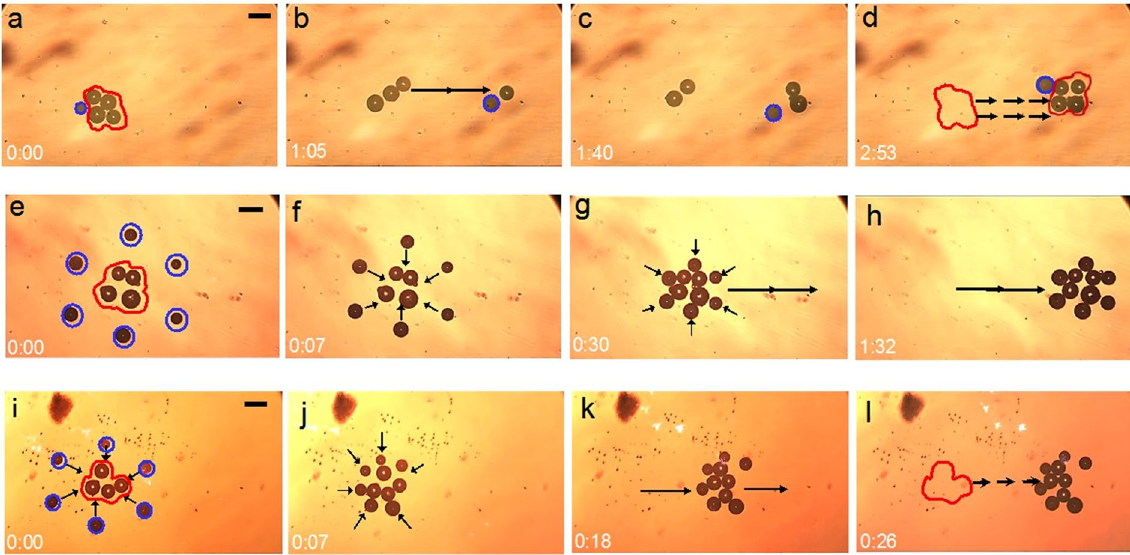
Figure 8. Cooperative microrobot transportation of multiple micro-objects. ( a–d ) An assembly of four glass beads was transported serially using a single OFB microrobot. ( a ) The OFB microrobot is circled in blue, and the four glass beads are enclosed by a red line. ( b–d ) The four glass beads were serially transported 844 µ m away from the initial location, over an assembly time of 2 minutes and 53 seconds. ( e–h ) Manually controlled cooperative microrobot transportation of multiple micro-objects. ( e ) Six microrobots are positioned equidistant from the glass beads. The microrobots are circled in blue, and the glass beads are enclosed by a red line. ( f ) The OFB microrobots were manually controlled to approach the beads to grasp them. ( g,h ) The glass beads were grasped by the microrobots, and the beads were transported to the delivery location. The assembly time was 1 minute, 32 seconds. ( i–l ) Automated cooperative microrobot transportation of multiple micro-objects. ( I,j ) The microrobots, circled in blue, grasped the glass beads enclosed by a red line. ( k ) The glass beads were grasped by the OFB microrobots and transported to the desired location. ( l ) The glass beads were transported from the initial position to the final destination in 26